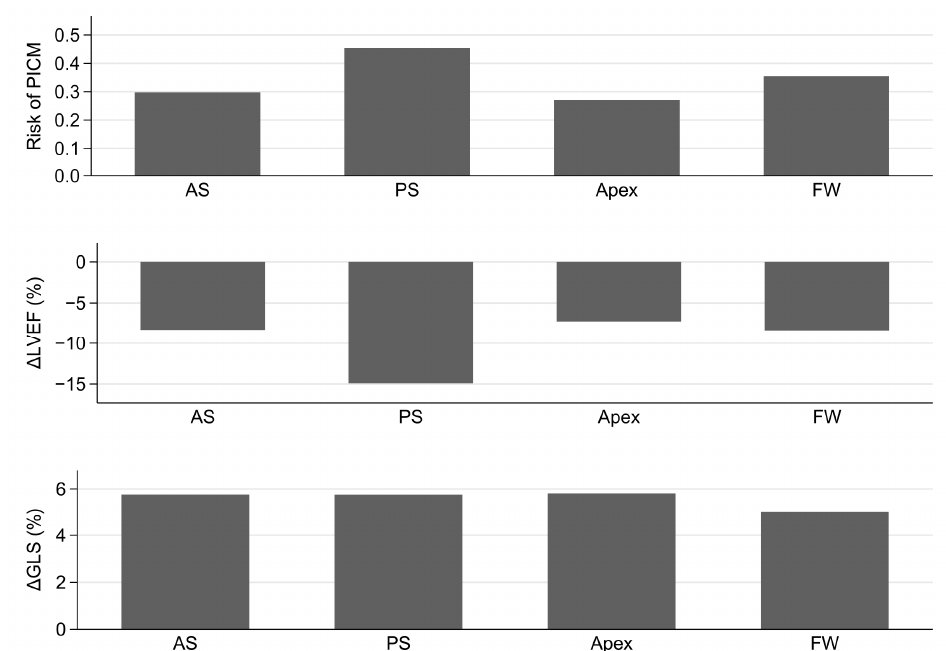
Figure 2. Comparison between anterior septal (AS), posterior septal (PS), apical, and free wall (FW) RV lead position. Upper panel: Risk of pacing-induced cardiomyopathy (PICM). Mid panel: Decrease in left ventricular ejection fract ( ∆ LVEF) after pacemaker implantation. Lower panel: Decrease in negative global longotudinal strain ( ∆ GLS) after pacemaker implantation.